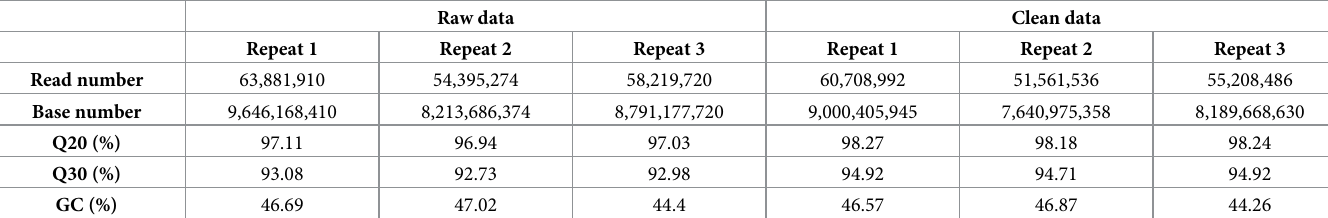
Table 1. Summary of sequencing results.